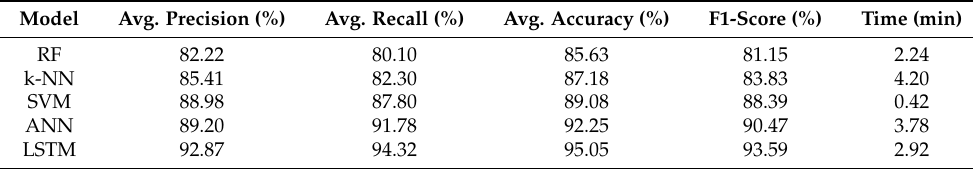
Table 4. Overall performance assessment using 10-fold